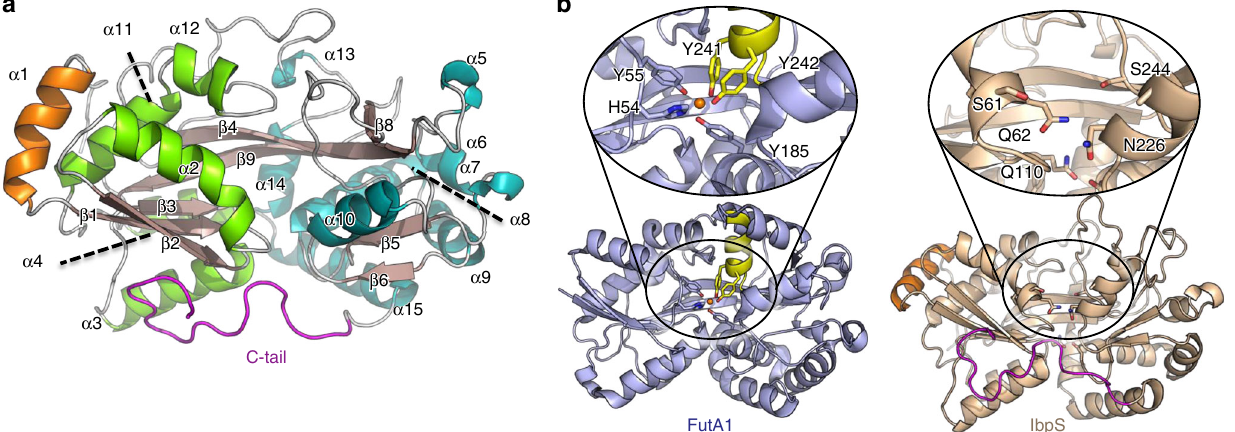
Fig. 3 Structure of IbpS. a Ribbon representation of the crystal structure of IbpS (chain A). β -strands are colored in brown, α -helices are colored in green (N-lobe) or blue (C-lobe) except for α 1 helix colored in orange. The C-terminal tail is colored in magenta. b Comparison of the iron-binding site of FutA1 (PDB code 3F11) with the corresponding residues in IbpS after superimposing the two structures. The iron atom is depicted as an orange sphere in FutA1. Residues Y241, Y242, Y55, Y185, and H54 coordinating iron in FutA1 are not conserved in IbpS. In particular the Y241/Y242-containing helix of FutA1 is replaced by a loop in IbpS, that has only a serine (S244) pointing towards the substrate-binding pocket